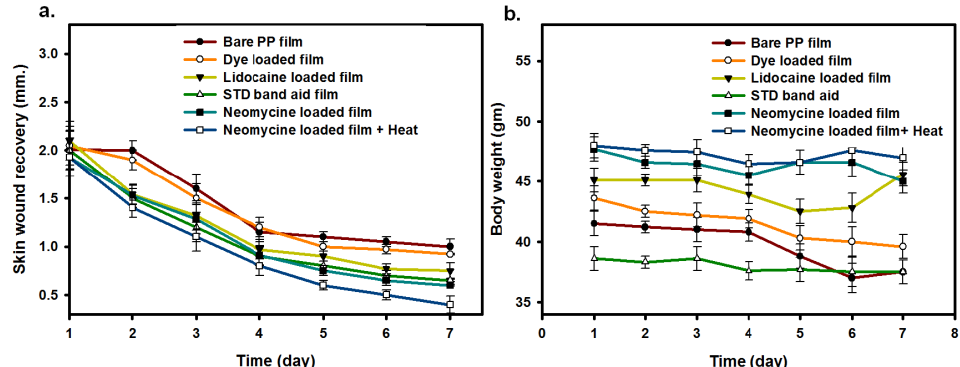
Figure 4. ( a ) Surgical incision average length (mm) and closure observed from day 1 to day 7 using bare PP film, dye (ICG)-loaded film, lidocaine-loaded film, neomycin-loaded film, STD (standard) Band-Aid film, and neomycin-loaded film with 5 min mini-heater treatment. The average incision length was quantified using digital slide calipers near the wound site. The mice were externally heated at 45 °C for 5 min in the heat groups (mean ± SD, n = 5). ( b ) The average body weight of treated mice when monitoring health status during in vivo studies.